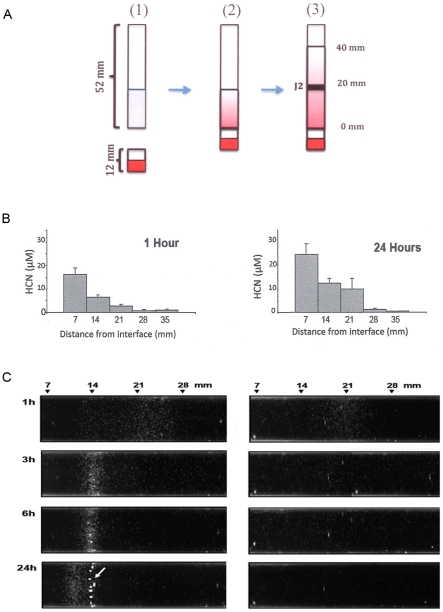
Response of nematodes to cyanide in a closed system.A. Diagram of assay design: (1) 23% PF-127 (grey shading) was added to 52 mm-long polystyrene tubing and KCN (red shading) was added to the donor tube (12-mm long). (2) After gel formed, the two tubes were connected. Hydrogen cyanide was produced in the donor tube then allowed to move across the airspace and to form a gradient upon re-dissolving in PF-127 gel in the assay tube. Gradient was allowed to form for 24 h. (3) J2s in PF-127 were layered into the assay tube and a layer of 23% PF-127 solution was pipetted on top. This addition was considered assay time point 0. B. Cyanide concentration measured at indicated distance from the interface assay tube and airspace of donor tube at 1 and 24 hr after time point 0. C. Tubes were photographed with side lighting to visualize the nematodes by reflected light at indicated times after assay start. A control experiment with no KCN in donor tube is shown on the right. Numbers at top correspond to distance (mm) from the bottom of the assay tube. The left-most 6 mm of the assay tube are not shown due to glare from the side lighting. The white arrow in C points to nematode clumps.